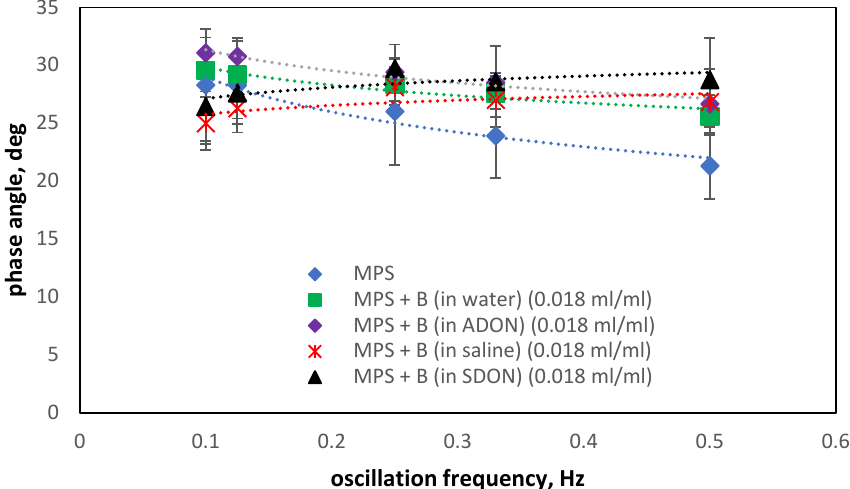
Figure 11. Changes of the phase angle in the oscillation of air/liquid interface with MPS (concentra- tion of 2.5 mg/mL) in presence of ADON or SDON and budesonide (B).